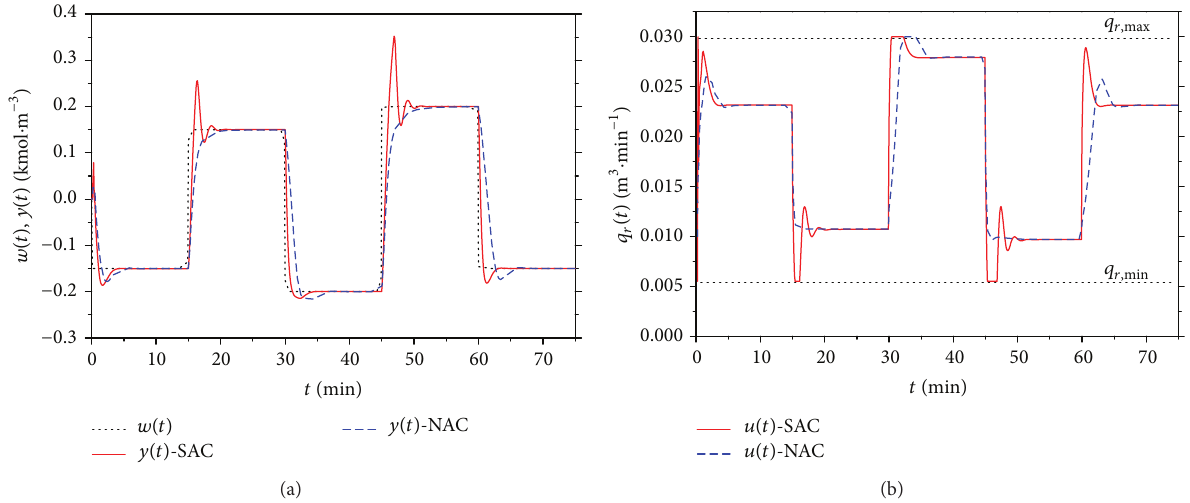
Figure 17: Comparison of resulted courses of output variable 𝑦(𝑡) (a) and input variable 𝑞 𝑟 (𝑡) (b) for nonlinear and classic adaptive control for 𝛼 =